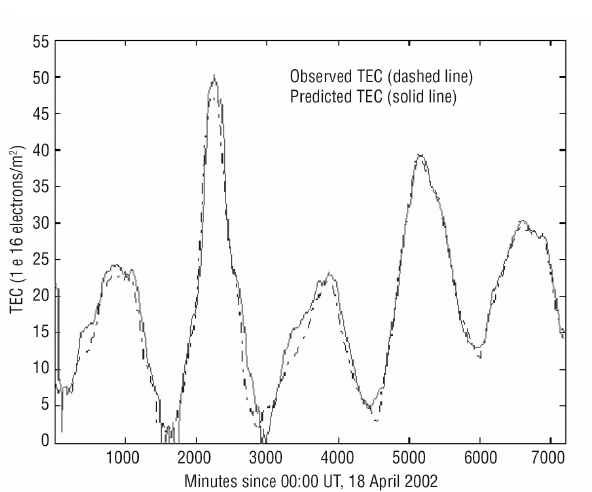
Fig. 3.16. Prediction of the GPS-TEC values from Hailsham on 18-22 April 2002, one hour ahead using the METU-NN